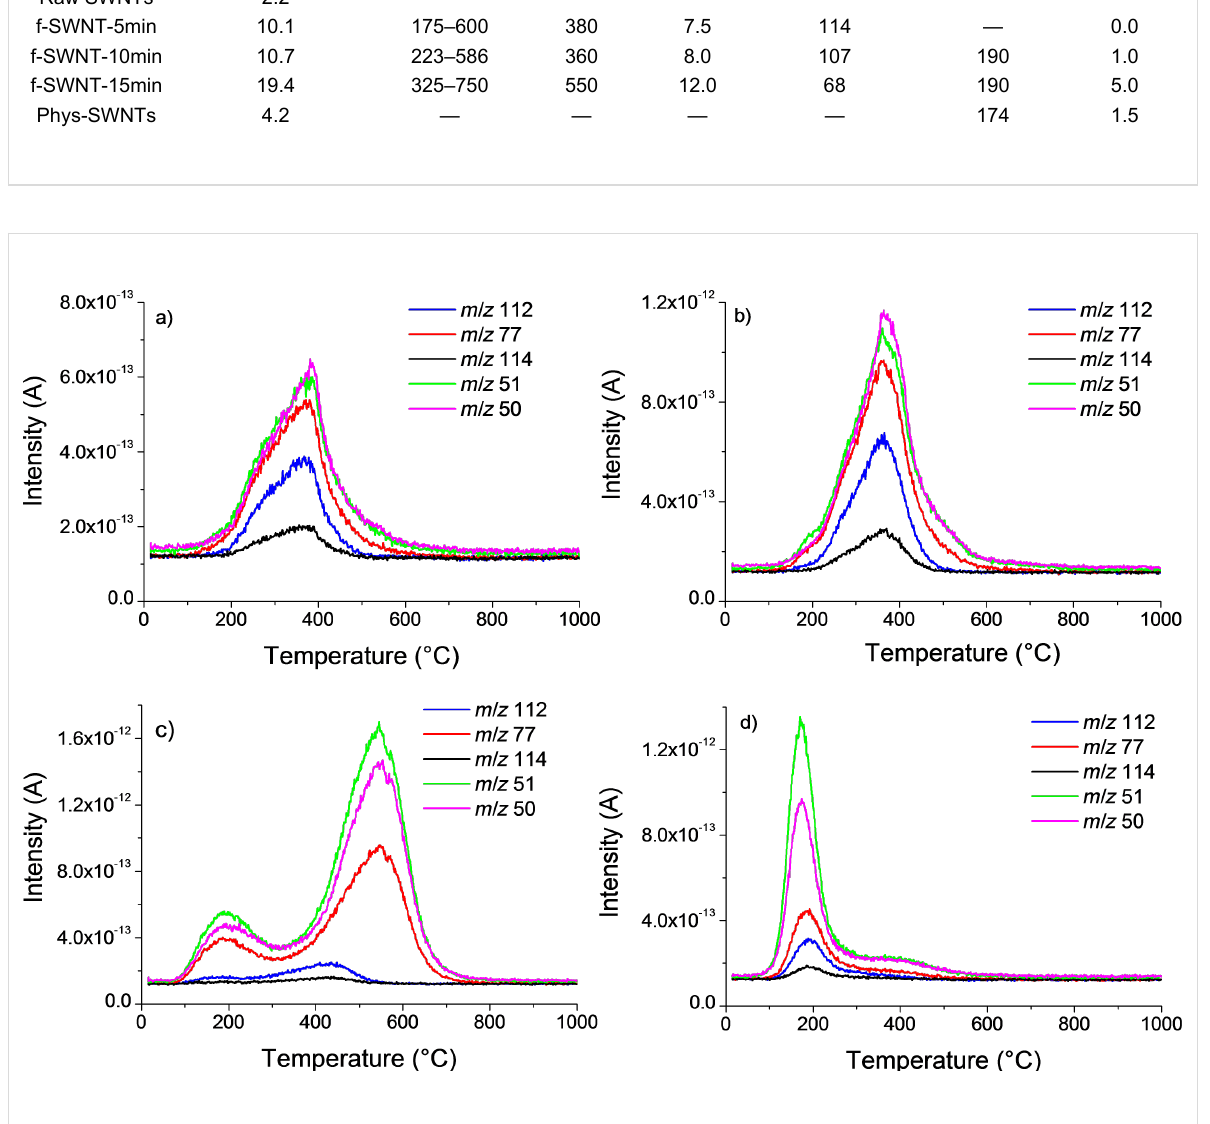
Figure 4: Mass spectrometry intensities for the main m / z corresponding to chlorobenzene. a) f-SWNT-5min, b) f-SWNT-10min, c) f-SWNT-15min, d) phys-SWNT.